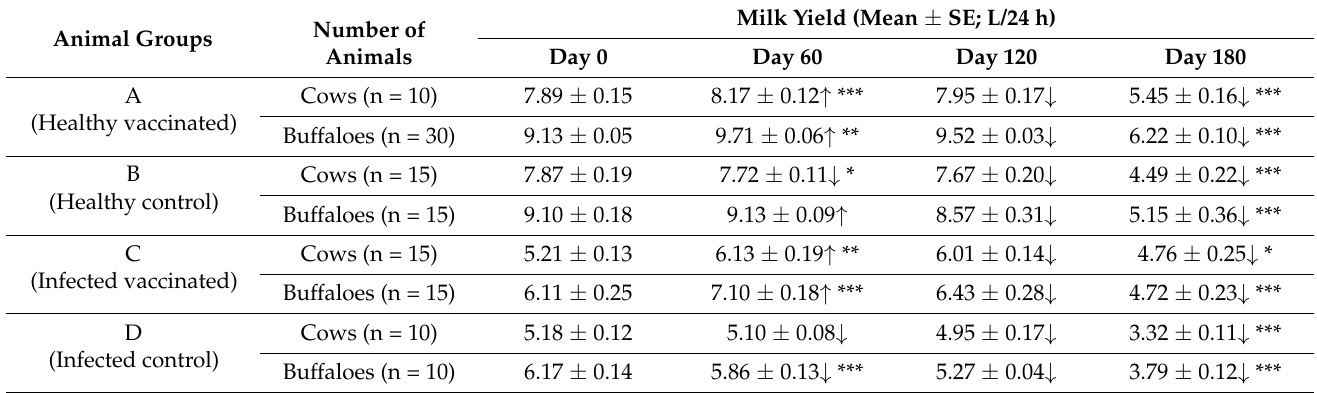
Table 4. Milk yield (Mean ± SE; L/24 h) of vaccinated and control groups at different post-vaccination